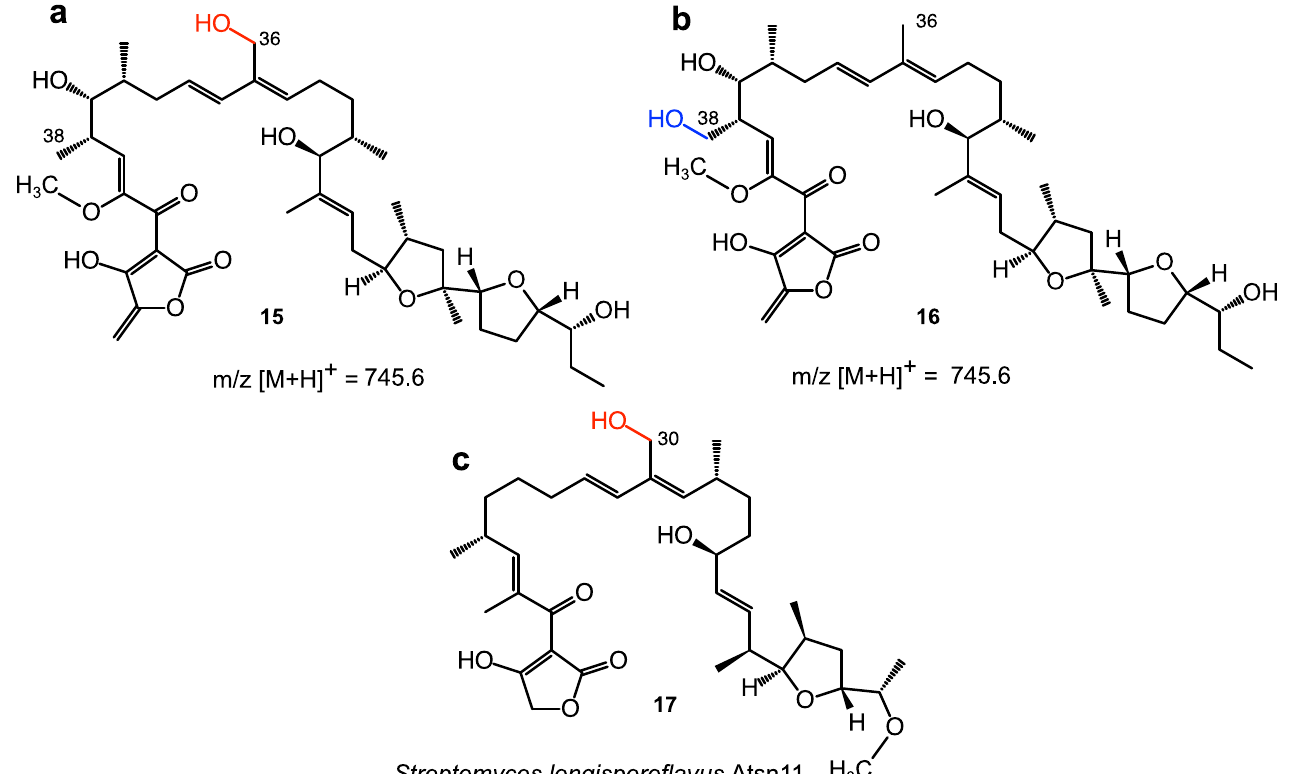
Fig 9. Possible structures of T-17. A . verrucosospora Δ mad10 no longer produces tetromadurin but produces a tetromadurin derivative, T-17. The mass spectrum of T-17 indicates that it is missing a primary hydroxyl group. The primary hydroxyl groups of tetromadurin are located at C36 and C38. Two possible structures of T-17 are therefore possible where either: a, the C38 hydroxyl group ( 15 ) or b, the C36 hydroxyl group ( 16 ) is absent. c, the structure of the tetronasin derivative 17 produced by Streptomyces longisporoflavus Δ tsn11 [7].